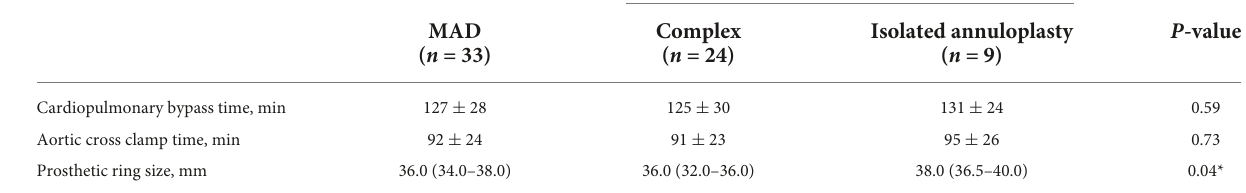
TABLE 5 Intraoperative